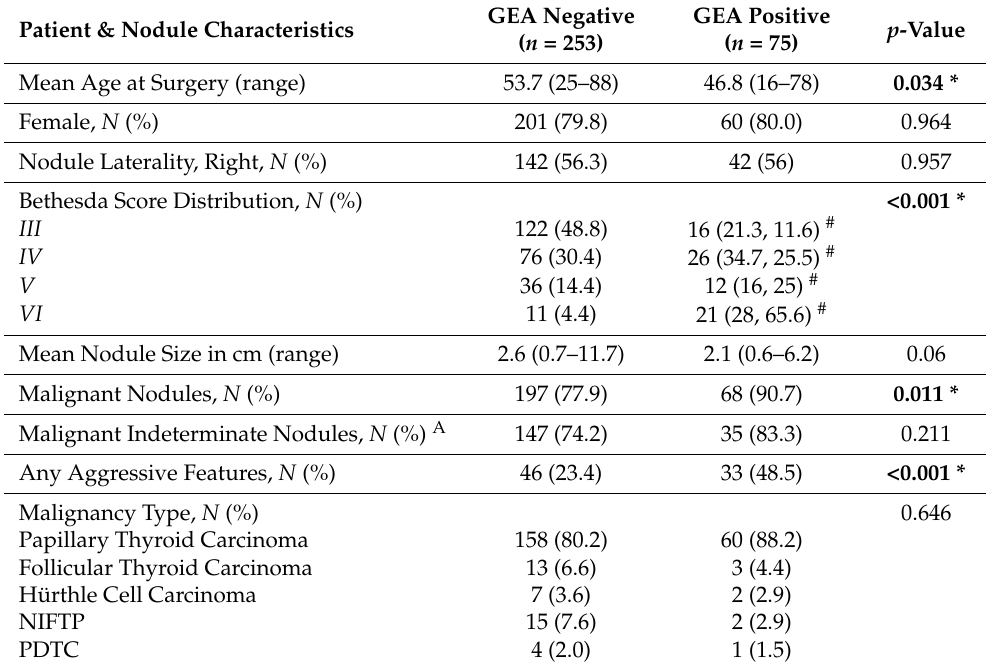
Table 1. Sociodemographic and Oncologic Characteristics of Thyroid Nodule Patients with and without Gene Expression Alterations.